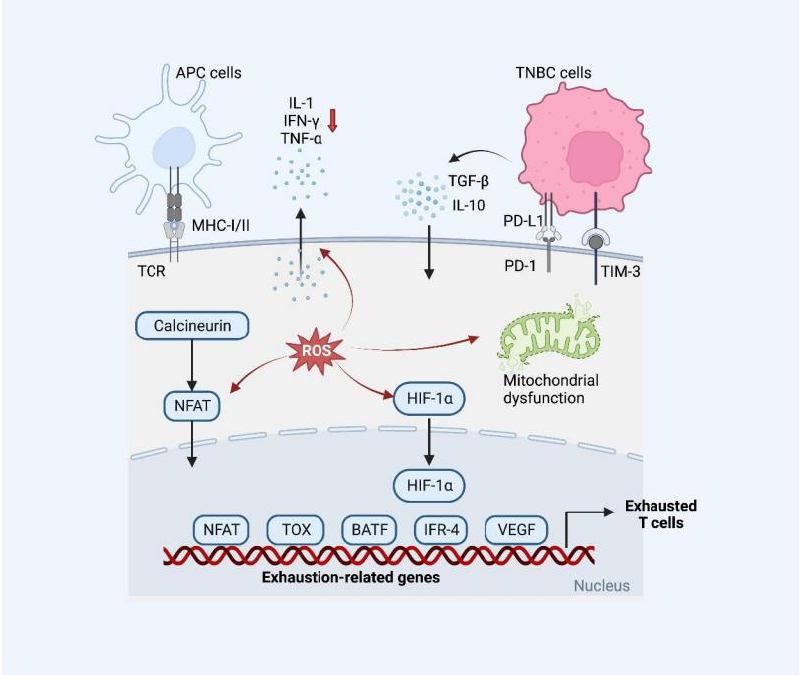
Figure 4. T cell exhaustion contributes to therapeutic resistance of TNBC to PD-1/PD-L1 inhibitors. Continuous exposure of T cells to tumor antigens and suppressive cytokines (IL-10, TGF- β ) leads to T cell exhaustion, which results in a poor response to immunotherapy and therapeutic resistance. The accumulated ROS, increased HIF- α and activated calcium-calcineurin-NFAT signaling pathway play a key role in T cell exhaustion, which contributes to therapeutic resistance. Abbreviations: PD-1, programmed cell death protein 1; PD-L1, programmed cell death 1 ligand 1; TCR, T cell receptor; MHC, major histocompatibility complex; APC, antigen-presenting cell; TNBC, triple negative breast cancer; TIM-3, T cell immunoglobulin domain and mucin domain-3; TGF- β , transforming growth factor-beta; IL-10, interleukin-10; IL-1, interleukin-1; IFN- γ , interferon- γ ; TNF- α , tumor necrosis factor- α ; ROS, reactive oxygen species; NFAT, nuclear factor of activated T cells; HIF-1 α , hypoxia inducible factor- 1α; TOX, thymocyte selection associated high mobility group box; BATF, basic leucine zipper transcriptional factor ATF-like; IFR-4, interferon regulatory factor 4.